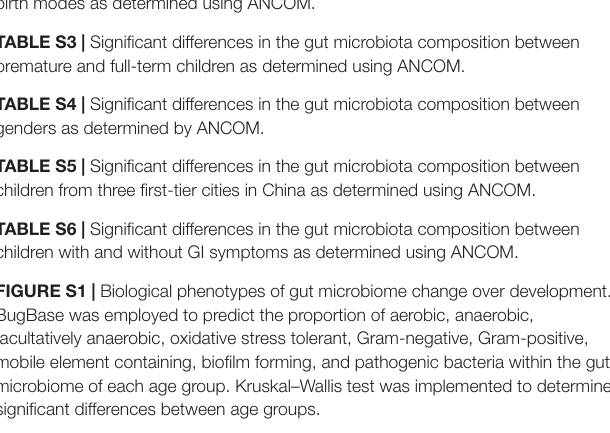
TABLE S1 | Characteristics of the enrolled children from each region.